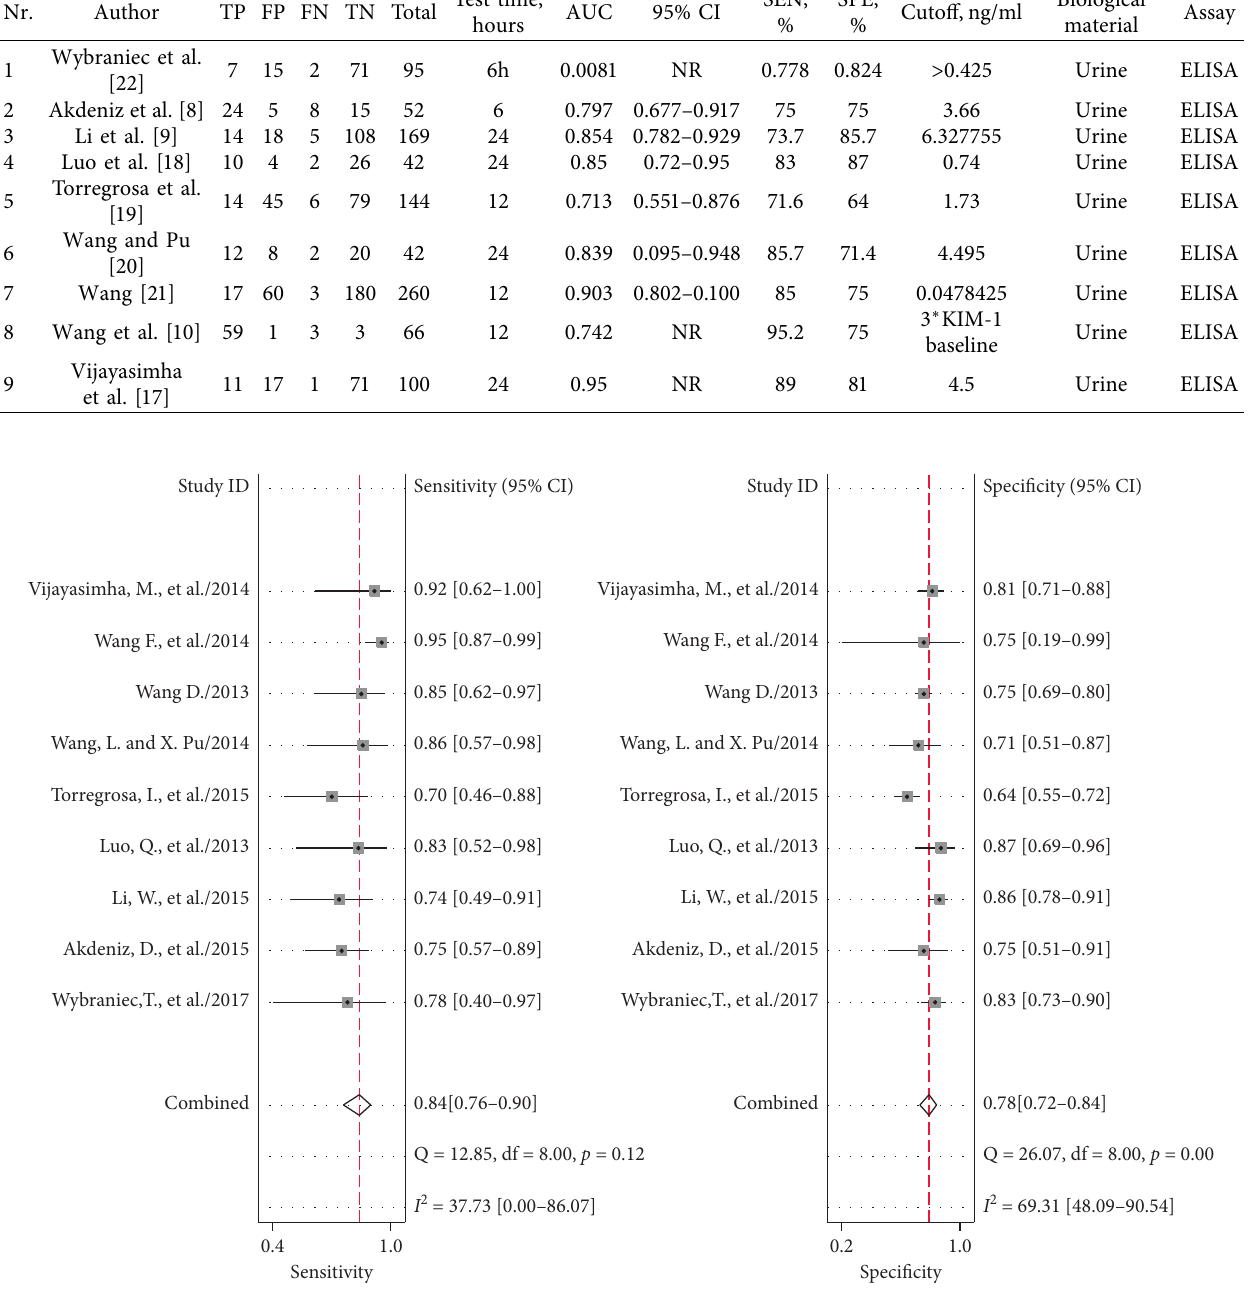
Figure 2: Forrest plots of the sensitivity and specificity of each individual study, summary sensitivity and specificity, and I 2 statistic for